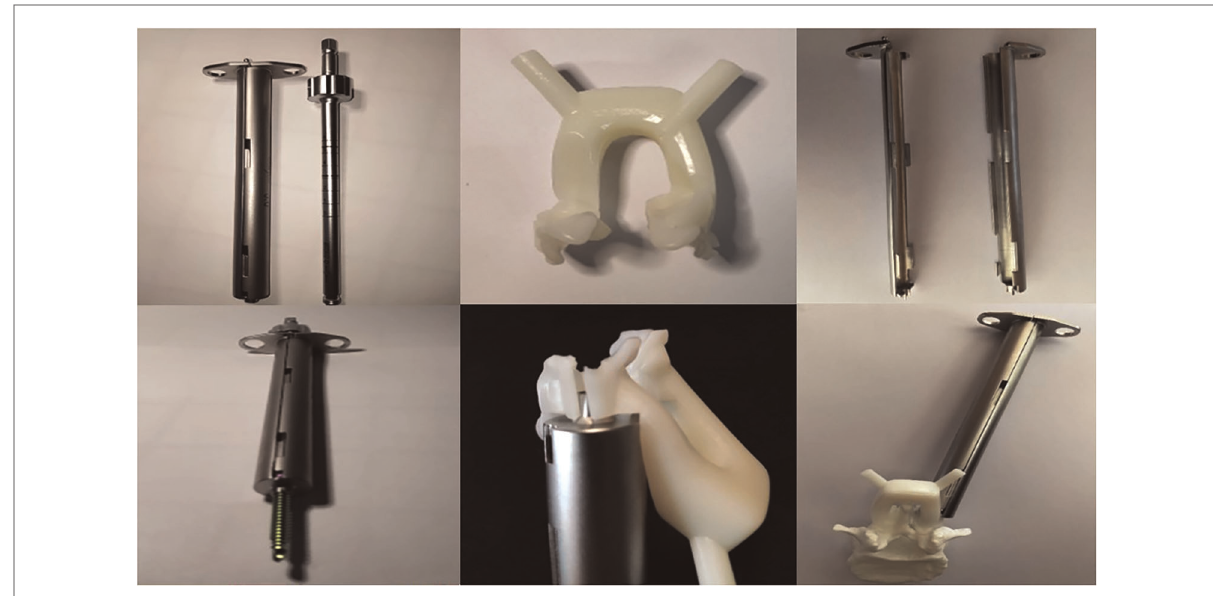
FIGURE 5 Removable minimally invasive 3D navigation system. The system provides a set of tools for the inner wall of metal for the nail setting channel, including the split metal sleeve combined with the long-rod metal screwdriver, supporting the fi fth generation of 3D guide plates to establish and extend the surgical channel. The screw can directly contact the bone interface through the surgical channel, reducing damage to blood vessels, nerves, and surrounding tissues, and reducing trauma. At the same time, the disassembly procedure is simple and